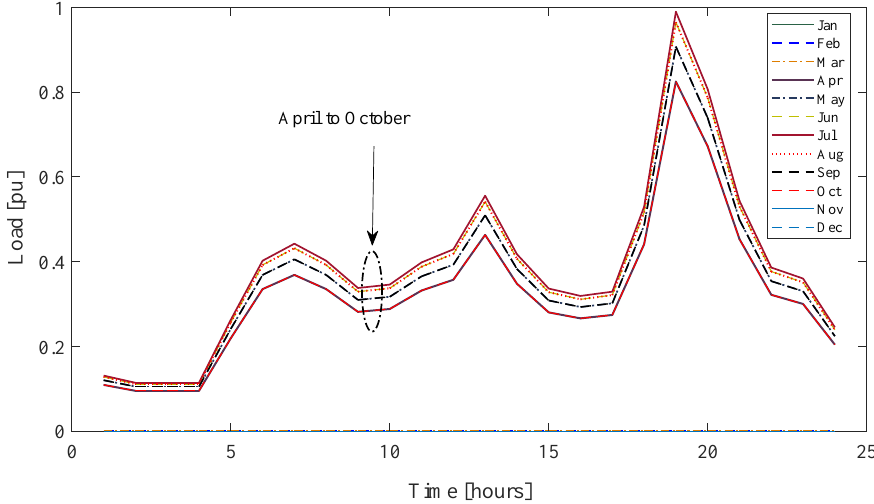
Figure 2. Daily load curve for weekdays throughout the